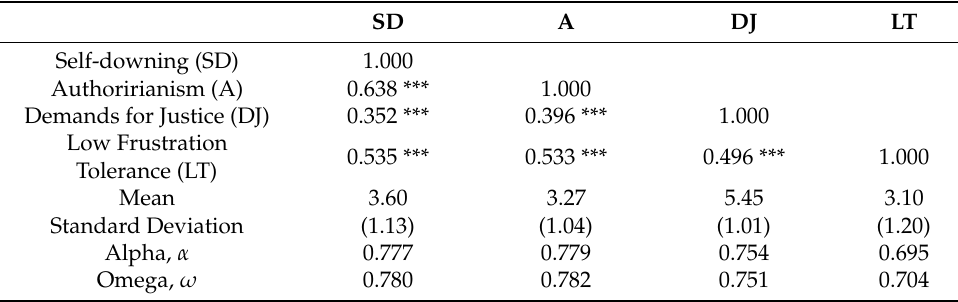
Table 3. Factor correlation matrix, means, standard deviations, and internal consistency measures (Alpha, α and Omega, ω